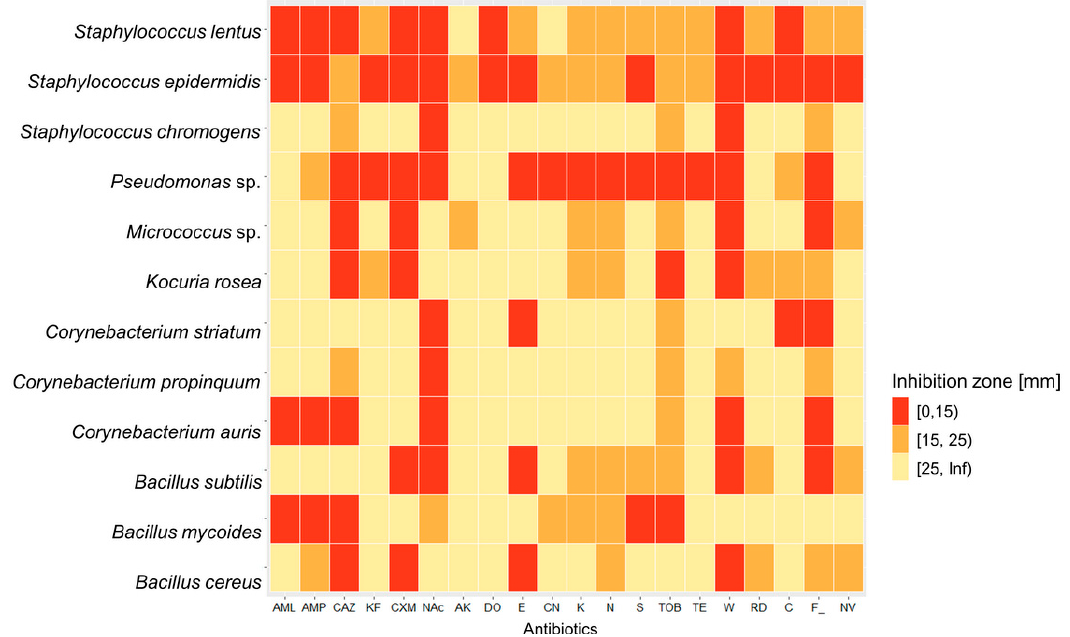
Figure 3. Results of antibiotic resistance testing. Expressed in the values of the growth inhibition zone (mm).